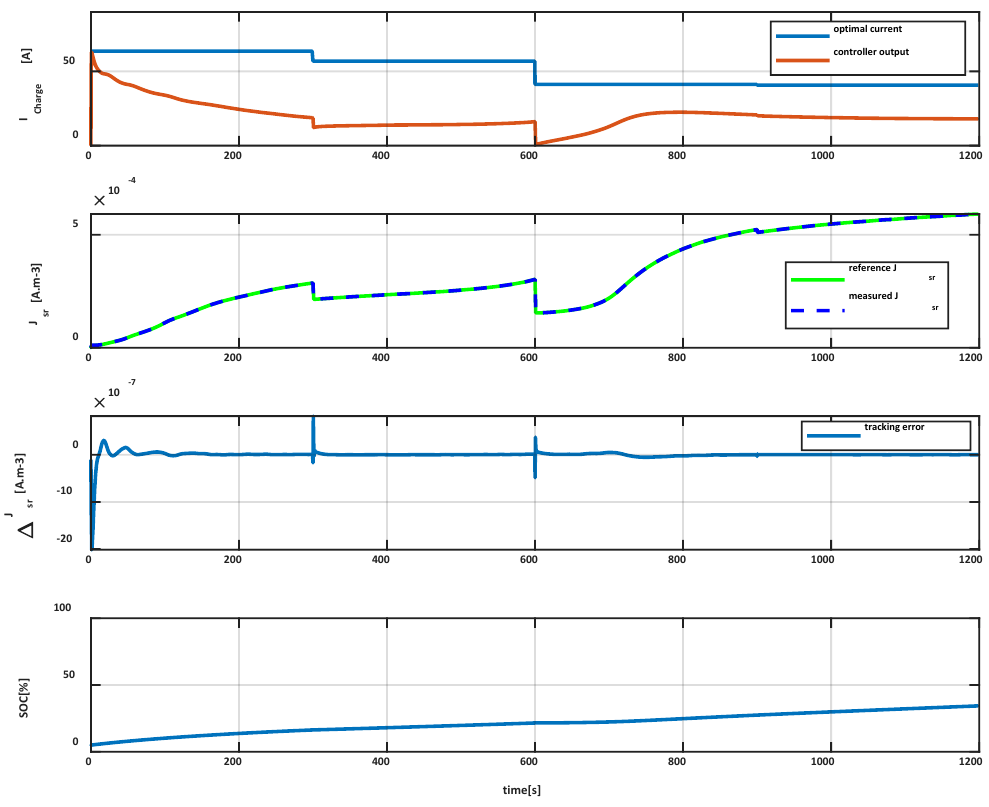
Figure 9. Impact of process variations on reference tracking.